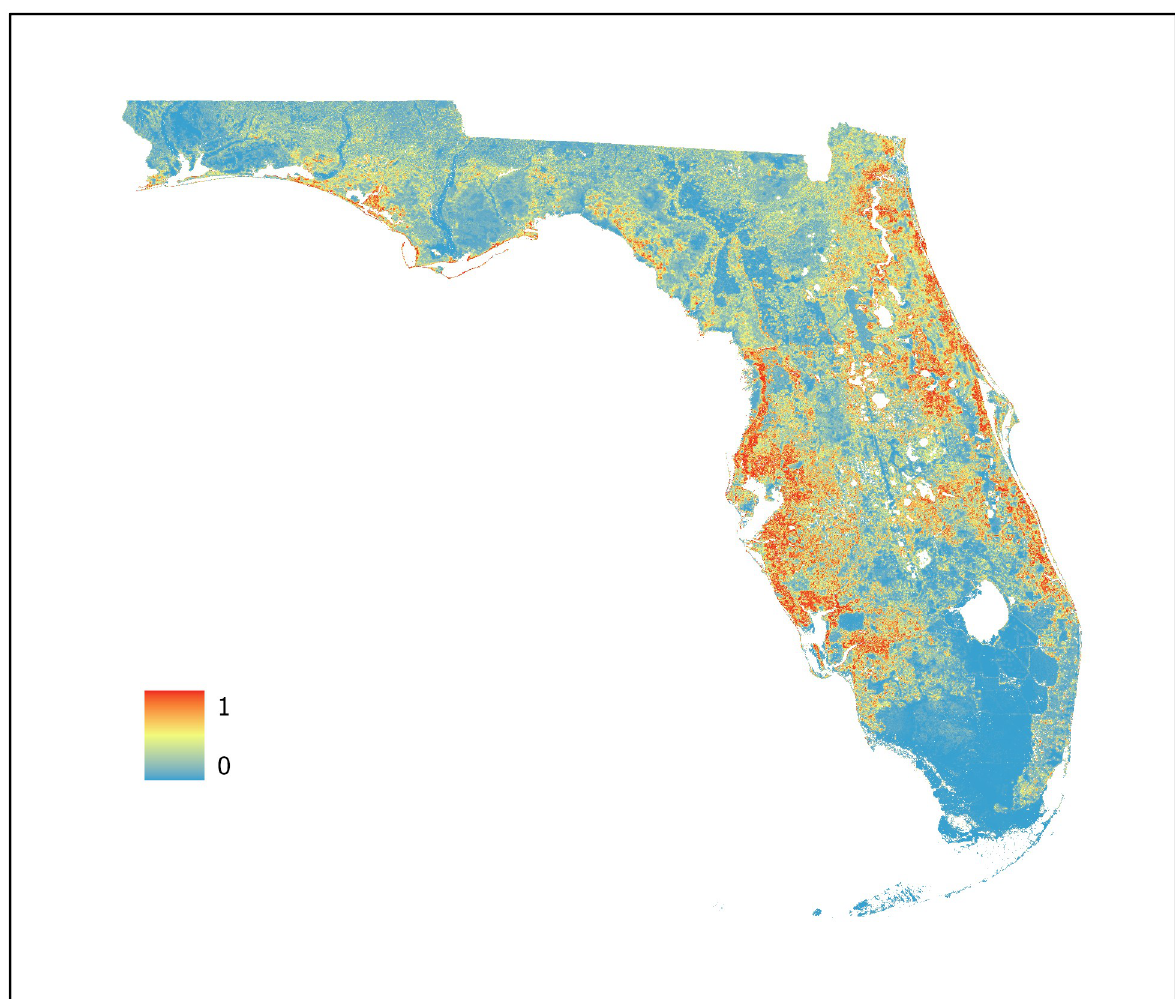
Fig 9. Maximum entropy model. Predictive values range from 0 to 1 with an AUC of 0.8728 (95% CI